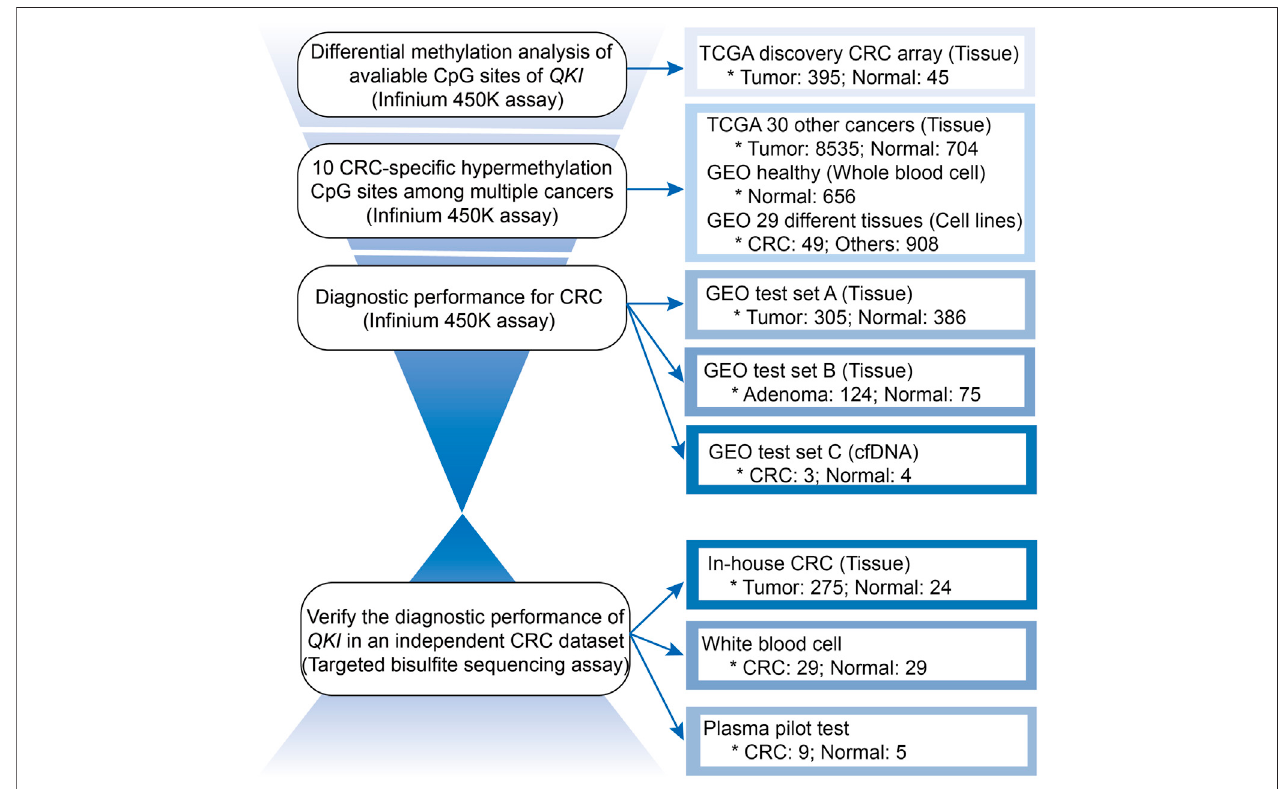
FIGURE 1 | Work fl ow for analyzing the methylation level of the QKI gene in multiple datasets.